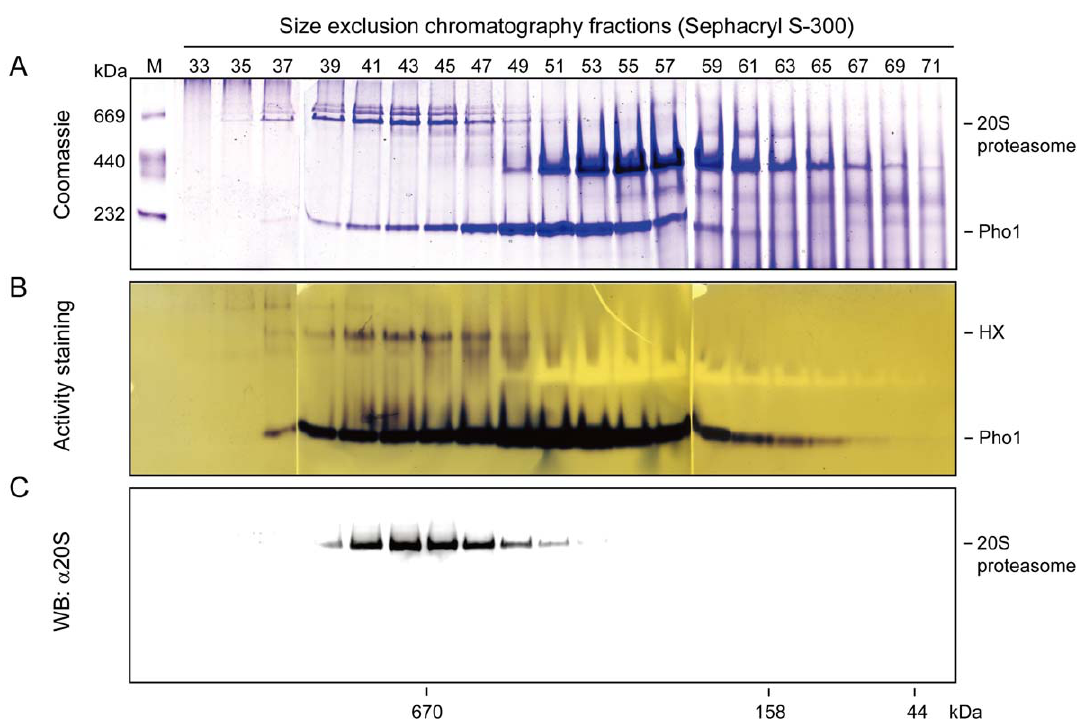
Figure 1. A high molecular weight complex (HX) showing Pho1 activity was found in the sweet potato roots. ( A ) The protein fraction from the extract of sweet potato roots was resolved by size-exclusion chromatography (Sephacryl S-300). The fractions (nos. 33 , 71) after chromatography were analyzed by 6% native PAGE, and then stained with Coomassie Brilliant Blue R-250 (Coomassie). The molecular mass markers (thyroglobulin (porcine thyroid ), 669 kDa; ferritin (equine spleen ), 440 kDa; catalase (bovine liver ), 232 kDa) were revealed in lane 1. ( B ) The native PAGE gel was incubated with the reaction buffer containing 20 mM MES-KOH (pH 5.9), 1.2% soluble starch and 32 mM Glc-1-P at 37 u C for 2 h. The zymogram was detected using iodine staining to reveal the catalytic activity of Pho1 in the direction of starch synthesis. Both of Pho1 and HX showed starch-synthesizing activity. The bands with negative staining were identified as beta amylase (BA). ( C ) The native PAGE gel was transferred to PVDF membranes and subsequently analyzed by western boltting with anti-20S proteasome antibody ( a 20S). The molecular mass in kilodalton (kDa) was shown as indicated on the bottom of the figure by applying the calibration of the size-exclusion chromatography column with known molecular mass standards (thyroglobulin (bovine), 670 kDa; c -globulin (bovine), 158 kDa; ovalbumin (chicken), 44 kDa). doi:10.1371/journal.pone.0035336.g001 western blot (Fig. 5A, Control, WB: H7c). Moreover, the L78 suggesting that heat treatment can trigger the proteolytic insertion was also completely removed as not detected by a L78 modification at the L78 insertion of Pho1 in sweet potato antibody on the western blot (Fig. 5A, Control, WB: a L78), roots. Interestingly, a different form of the 20S proteasome with